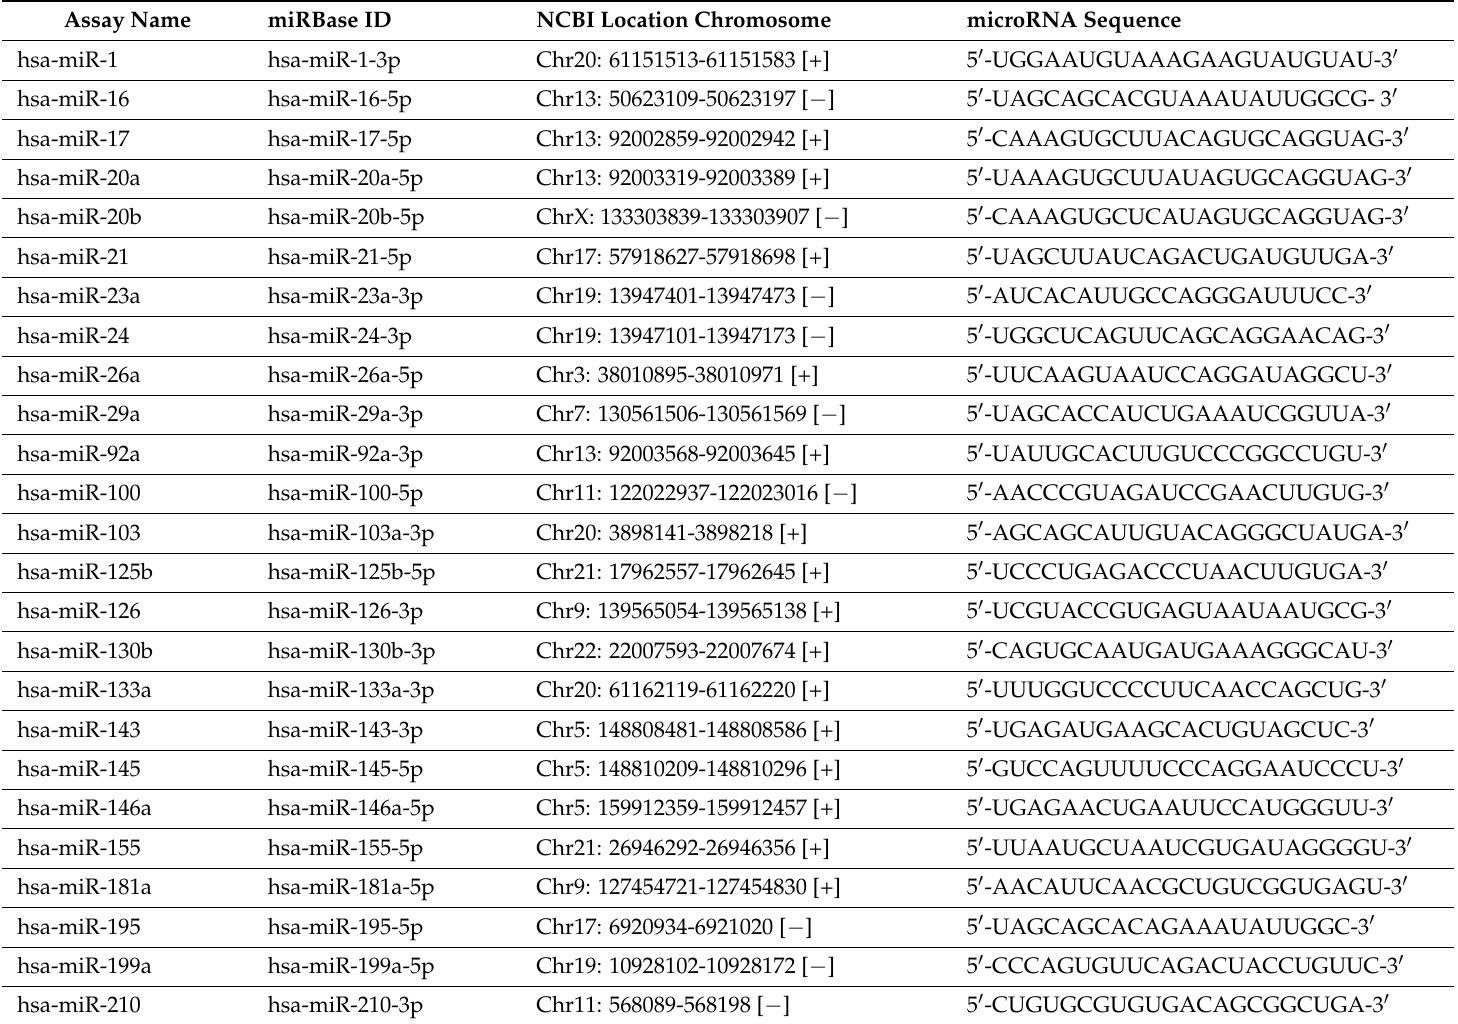
Table 4. Characteristics of microRNAs involved in the